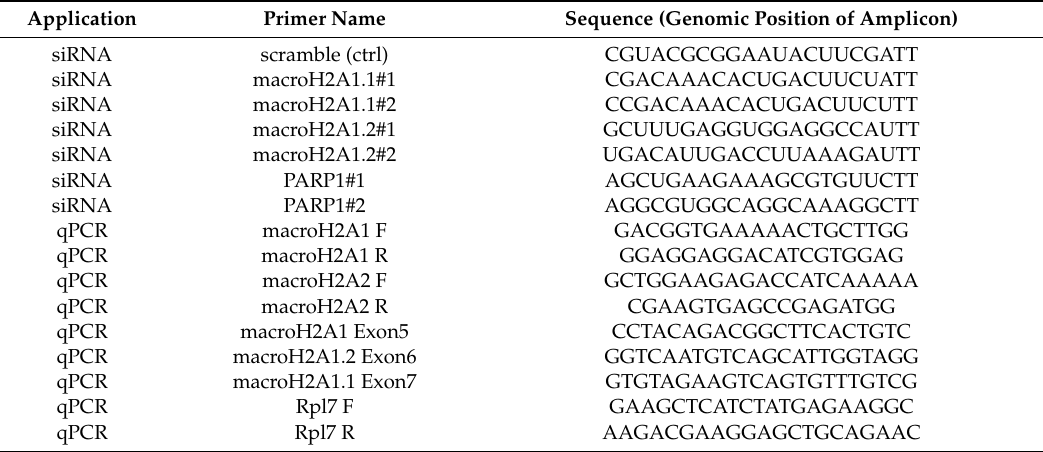
Table A1. Primer